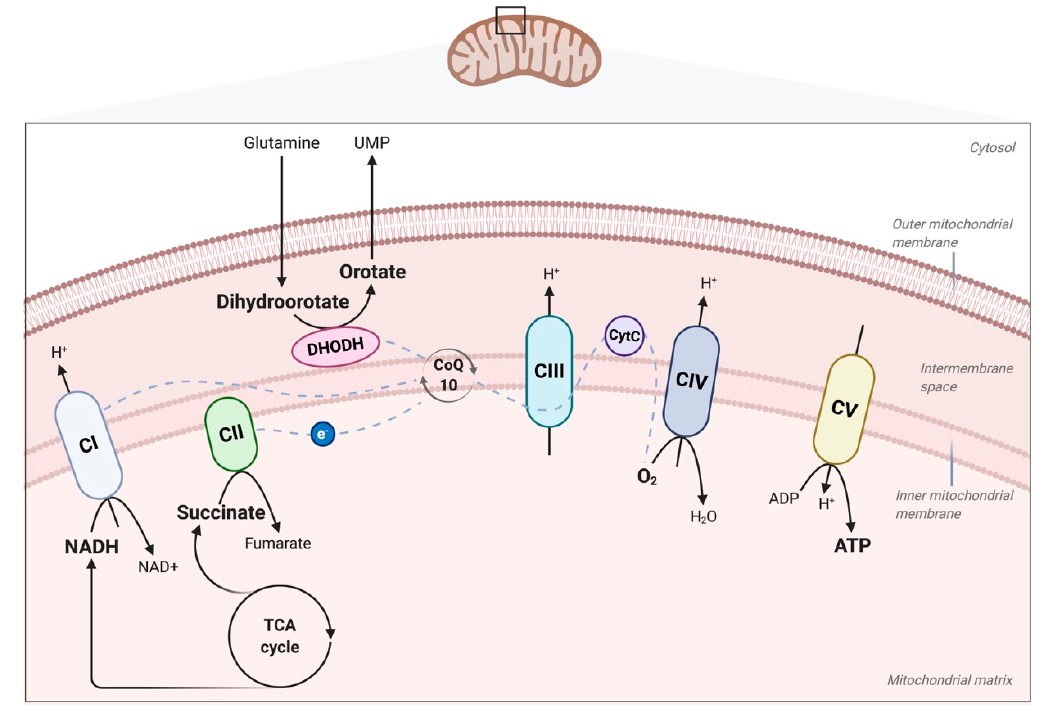
Figure 1. Oxidative phosphorylation (OXPHOS) through the electron transport chain (ETC) and adenosine triphosphate (ATP) production. OXPHOS is the process leading to ATP synthesis through the transport of electrons released by the oxidation of nicotinamide adenine dinucleotide (NADH) and succinate generated by the tricarboxylic acid (TCA) cycle. The transport of electrons is mediated by the ETC located in the mitochondrial inner membrane. The ETC is composed of the four complexes NADH–ubiquinone oxidoreductase (complex I), succinate–CoQ oxidoreductase (complex II), ubiquinol–cytochrome c oxidoreductase (complex III), and cytochrome c oxidase (complex IV), and of the free-electron carriers ubiquinone (CoQ10) and cytochrome c (CytC). Electrons are transferred through the ETC and finally to oxygen (O 2 ) (dashed lines). This electron transfer is accompanied by a flow of protons (H + ) from the mitochondrial matrix into the intermembrane space, across complexes I, III, and IV. The generated transmembrane electrochemical proton gradient allows the ATP synthase (complex V) to produce ATP. Also shown is the dihydroorotate dehydrogenase (DHODH), which participates in the electron transfer process through the oxidation of dihydroorotate to orotate, leading to de novo pyrimidine synthesis.